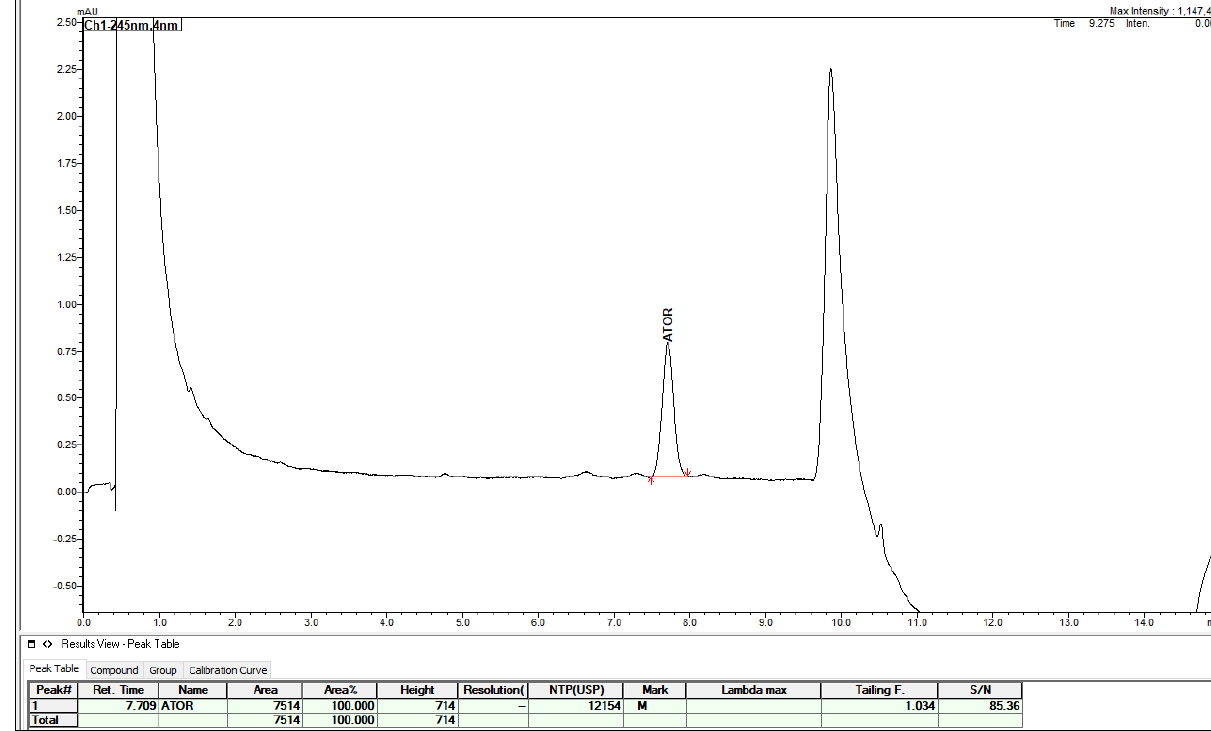
Figure 5. Chromatogram of the diluted test solution of atorvastatin corresponding to 0.1% of its concentration in the test solution prepared as for substance analysis criteria, with system suitability parameters.